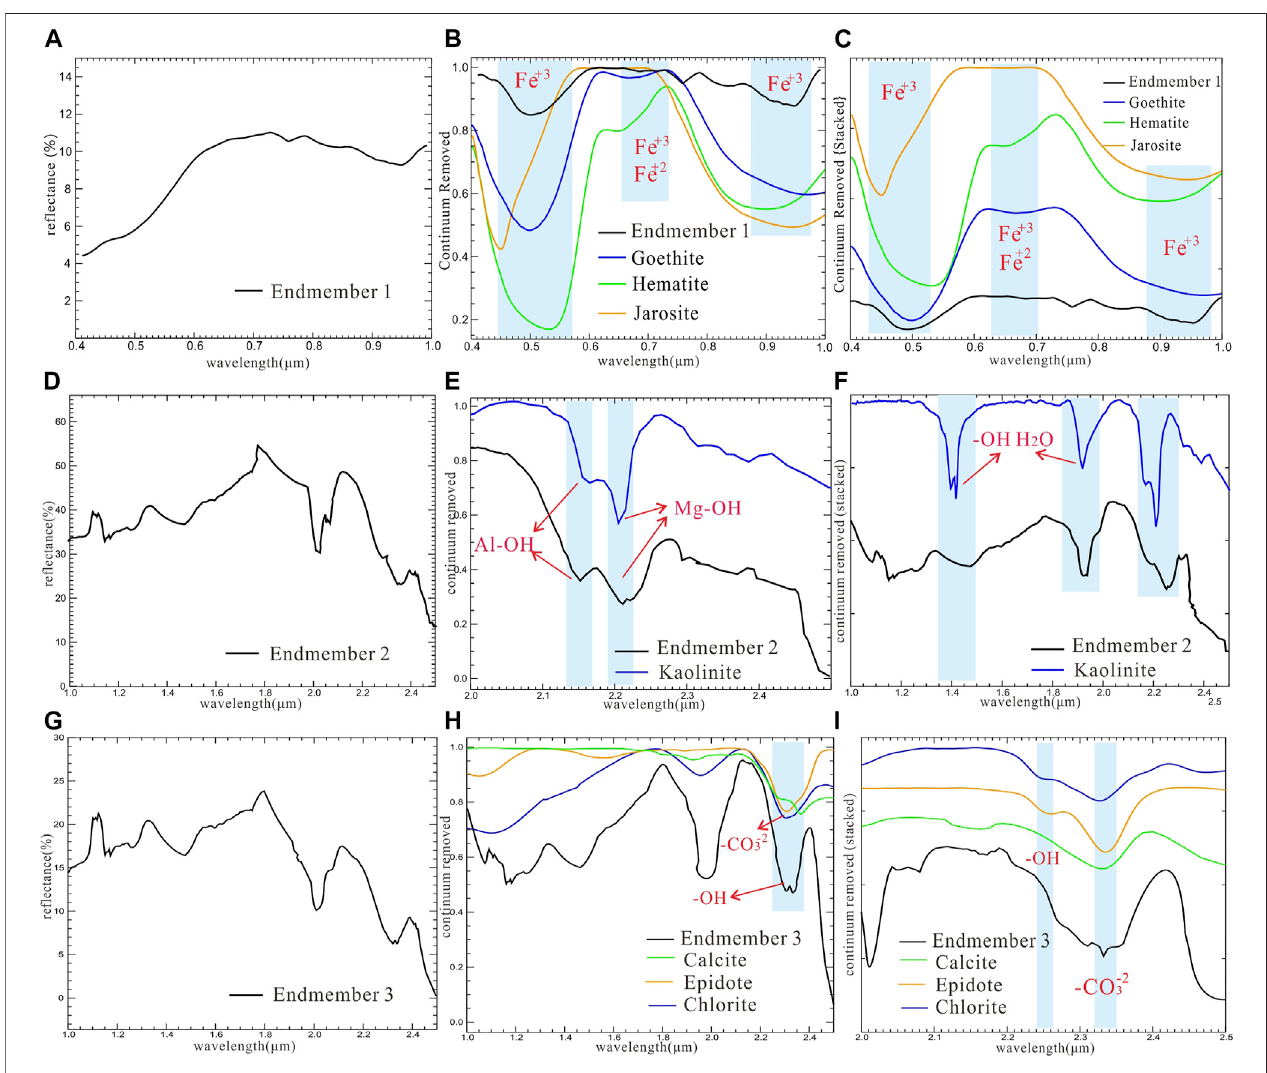
FIGURE 7 | Endmember spectra. (A) , (B) , and (C) Endmember 1/iron oxide minerals; (D) , (E) , and (F) endmember 2/clay alteration; and (G) , (H) , and (I) endmember 3/propylitic alteration; (A) , (D) , and (G) re fl ectance of the endmember spectra; (B) , (E) , and (H) continuum removal spectra of endmembers and standard spectra; (C) , (F) , and (I) continuum removal spectra (stacked) of endmembers and standard